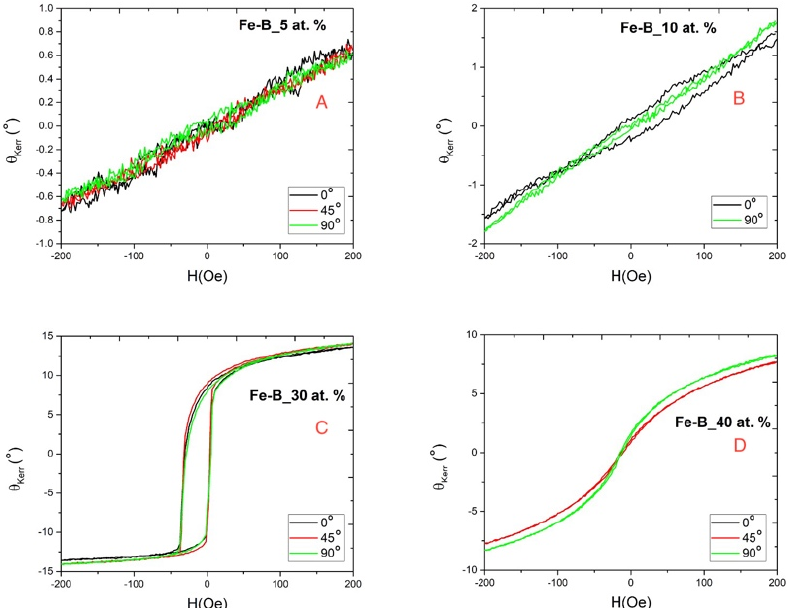
Figure 10. MOKE hysteresis loops for Fe ‐ B films obtained by MS. Different orientations of the mag ‐ netic field with respect to a reference in plane direction are considered. ( a ) is Fe ‐ B 5 at. %, ( b ) is Fe ‐ B 10 at. %, ( c ) is Fe ‐ B 30 at. %, and ( d ) is Fe ‐ B 40at. %.